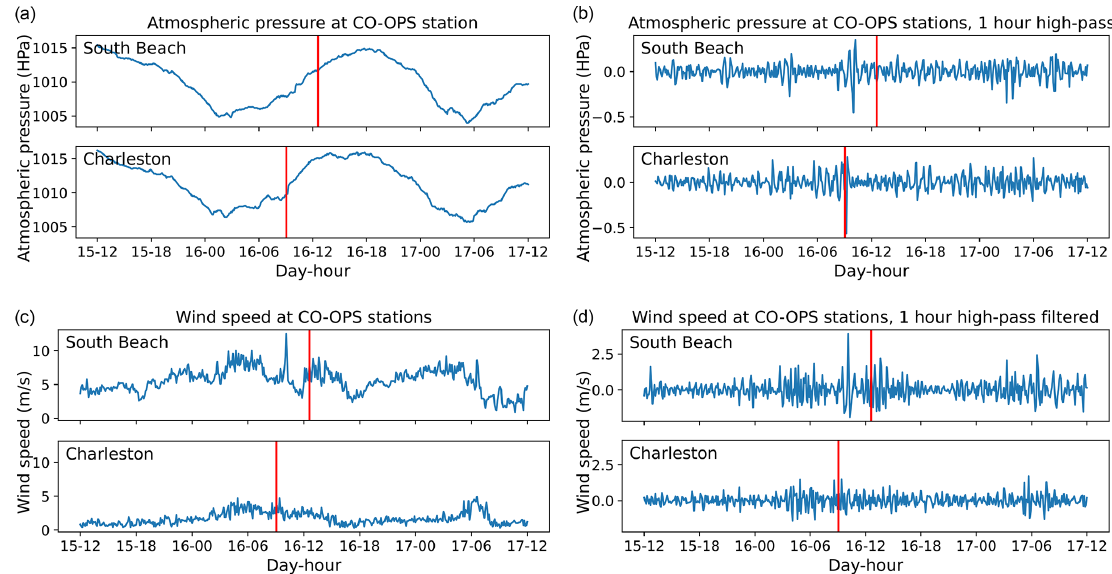
Figure 7. Atmospheric pressure and wind speed (a, c) at South Beach and Charleston tide gages from 15 January, 12:00, to 17 January, 12:00, in 2016. Vertical red lines indicate 12:36 and 09:03 on 16 January for South Beach and Charleston, respectively, i.e., the approximate onset of unusual water level fluctuations at the tide gages. (b, d) The 1h high-passed version of (a) and (c) .